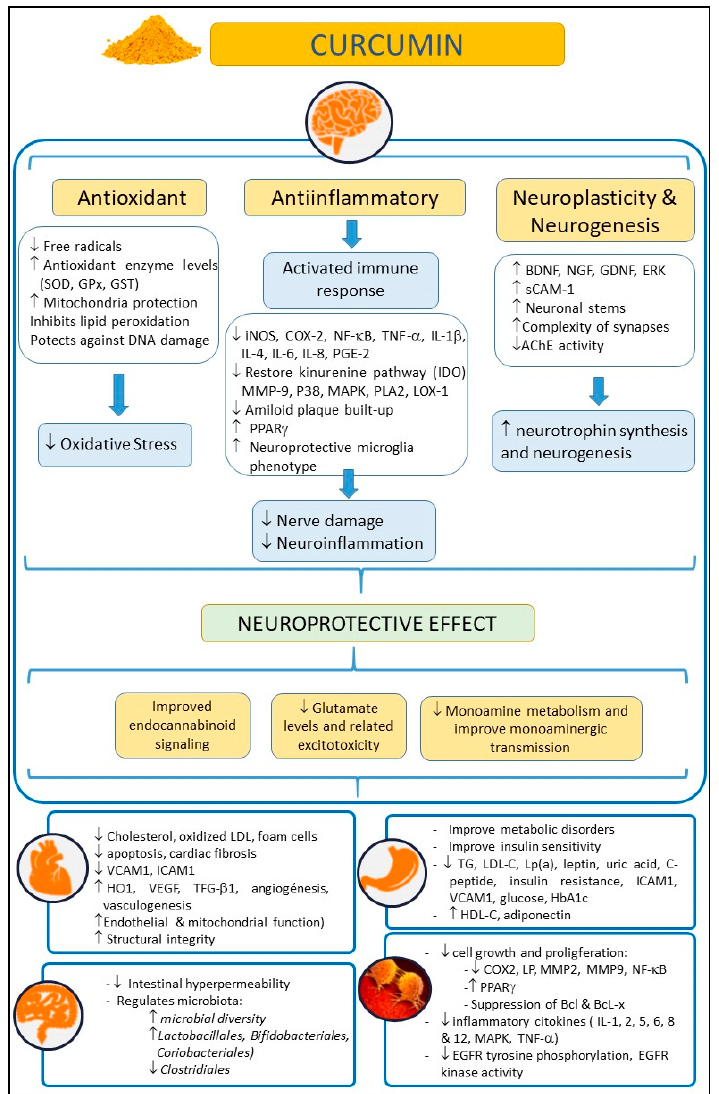
Figure 1. Summary of potential beneficial effects of curcumin on health, in neurological, cardiovas- cular, intestinal, metabolic, and oncological disorders. Abbreviations: AChE: acetylcholinesterase; Bcl: B-cell lymphoma; BDNF: brain-derived neurotrophic factor; COX-2: cyclooxygenase 2; EGFR: epidermal growth factor receptor; ERK: extracellular-regulated kinase; 9 GDNF: glial cell line-derived neurotrophic factor; GPx: glutathione peroxidase; GSH: glutathione; GST: glutathione S-transferase; HbA1c: glycosylated hemoglobin A1c; HDL-C: high density lipoprotein cholesterol; HO-1: heme- oxygenase-1; ICAM-1: intercellular adhesion molecule-1; IL: interleukin; iNOS: inducible nitric oxide synthase; IL-10: Interleukin-10; LDL-C: low density lipoprotein cholesterol; LOX-1: lectin-like